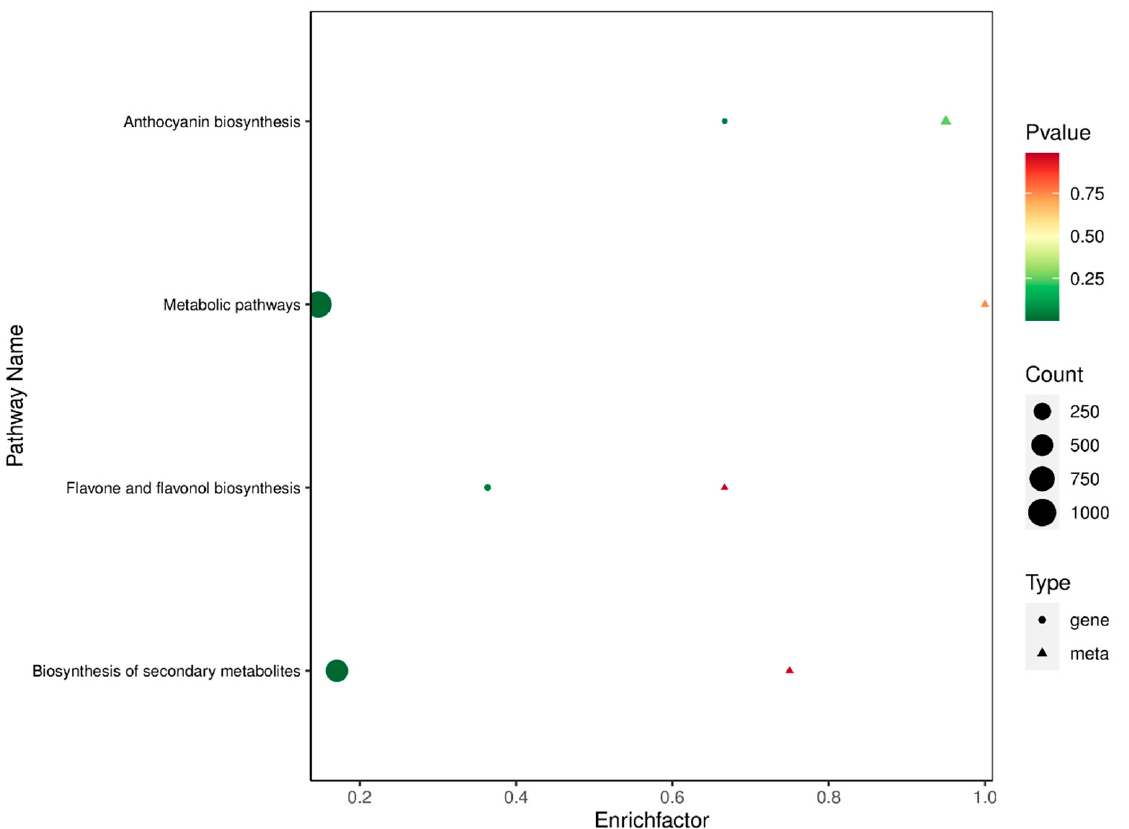
Figure 7. Bubble diagram for the combined analysis of differential genes and metabolites between G (Baitao K, green calyx) and R (FZ-72, red calyx).